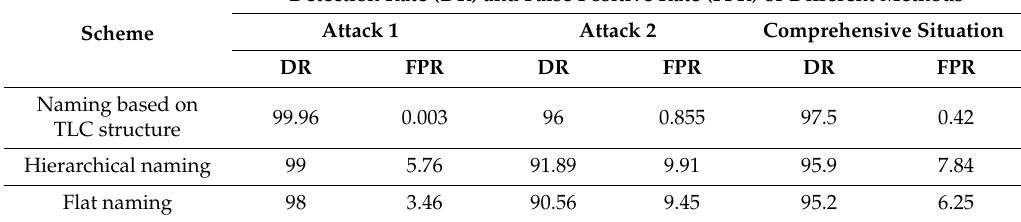
Table 7. Comparison of detection rate (DR) and false positive rate (FPR) results of di ff erent methods in attack 1 and attack